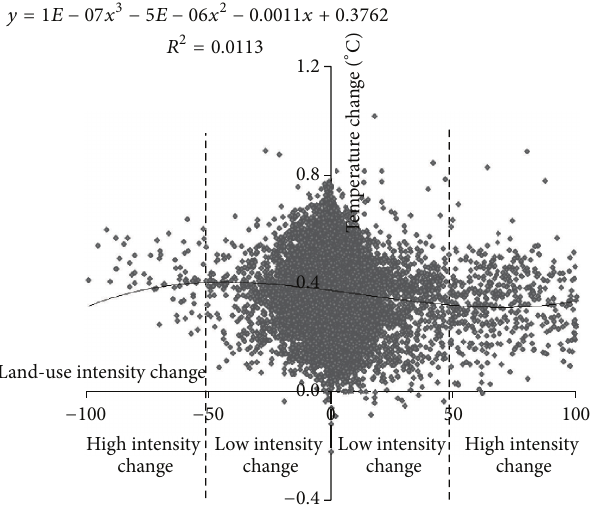
Figure 7: The dynamic relationship of temperature and land-use intensity variations over 10 years (2001–2011).